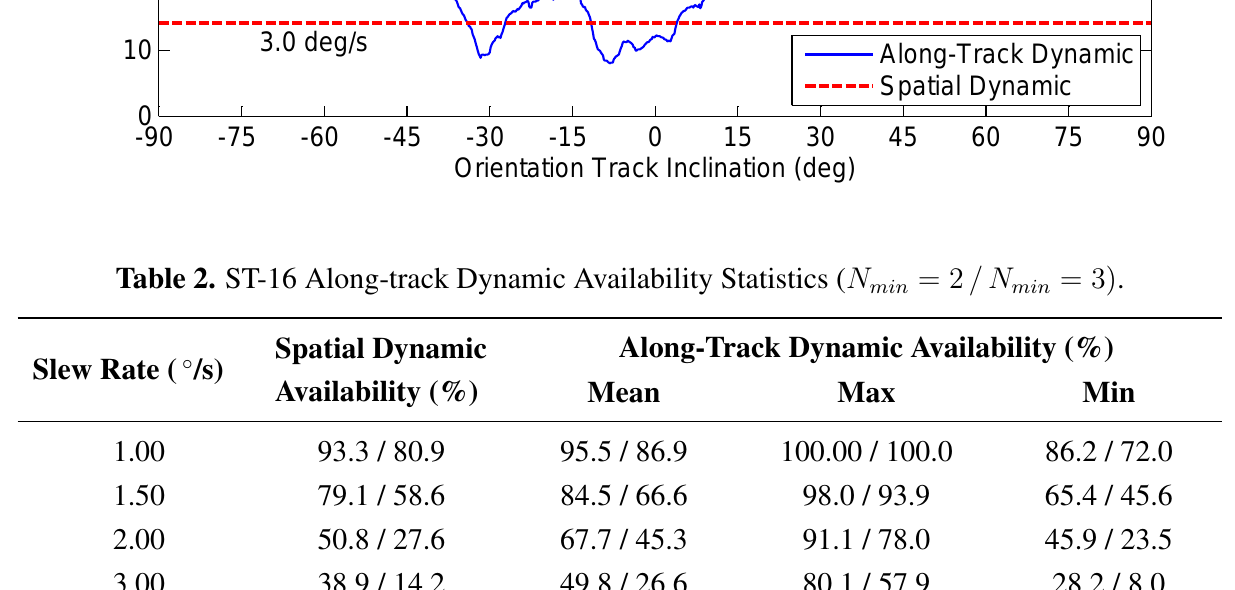
Table 2. ST-16 Along-track Dynamic Availability Statistics ( N